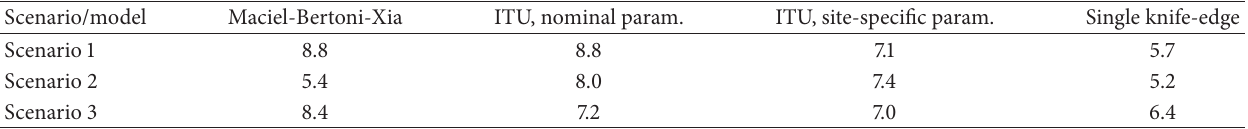
Table 1: Root mean square error